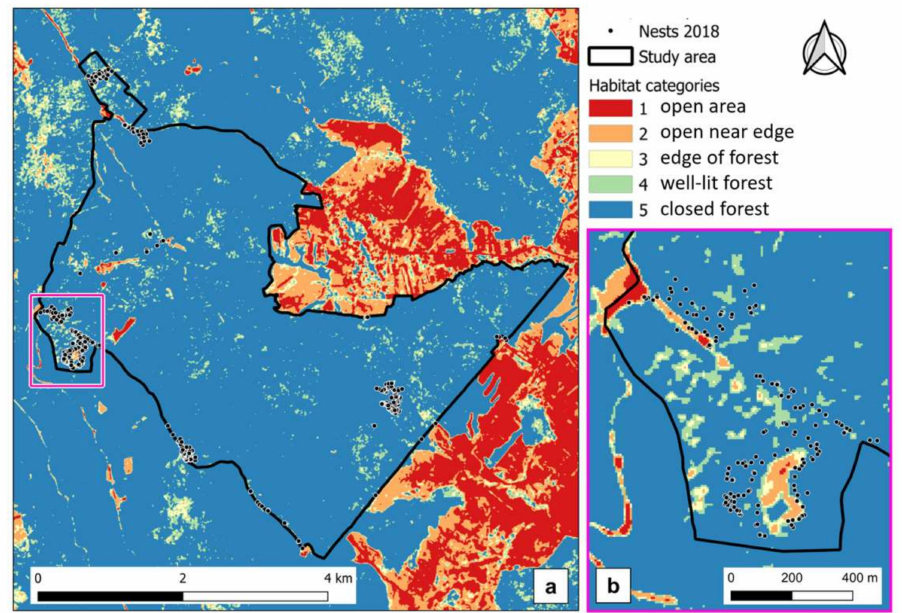
Figure 5. Stand canopy cover categories produced on the NDVI map ( a ) and detailed view of section with RWA nests 2018 ( b